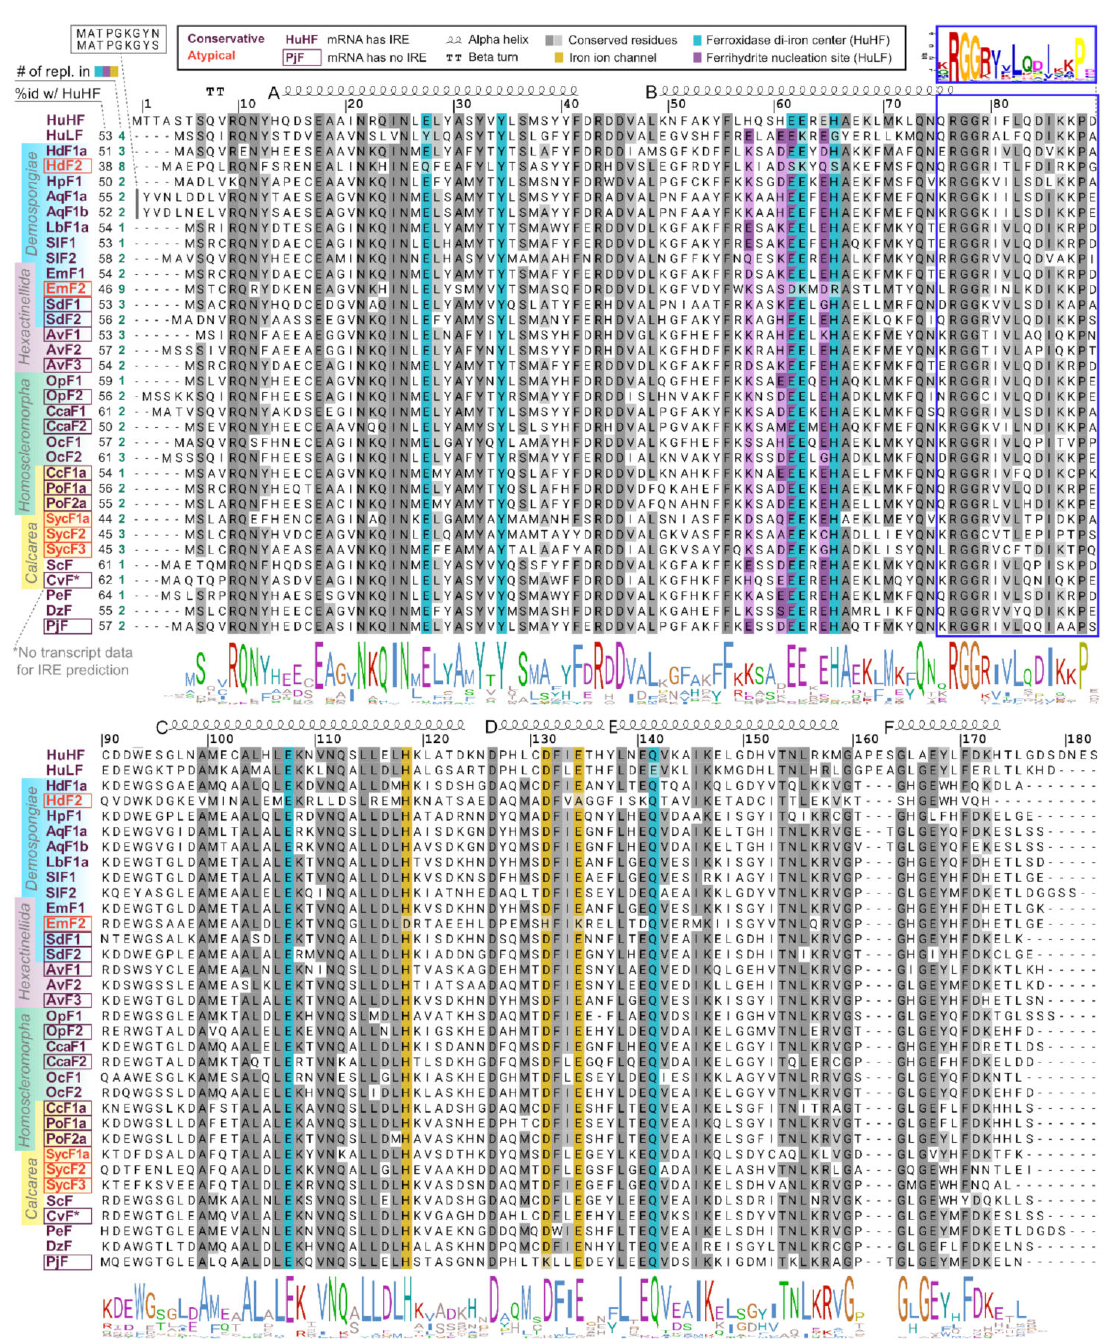
Figure 2. Domains and secondary structure of sponge ferritins. Alignment of ferritin amino acid sequences of H. sapiens , sponges of four classes, and five invertebrate species whose crystallographic data was recently obtained (the accession numbers are in Supplementary Table S1, for some species, only one representative gene copy product is shown). Amino acids numbering corresponds to conventional human HuHF numbering starting after the initial methionine. Highlighted are residues of three ferritin domains: iron ion channel (yellow), ferroxidase di-iron center (cyan), and ferrihydrite nucleation site (purple). To the left of the alignment are shown identity percentage level with human HuHF and the number of replacements in three domains. HuHF secondary structure is shown schematically above the alignment (PDB ID: 3AJO). A motif for the non-classical endosome secretion pathway is framed with